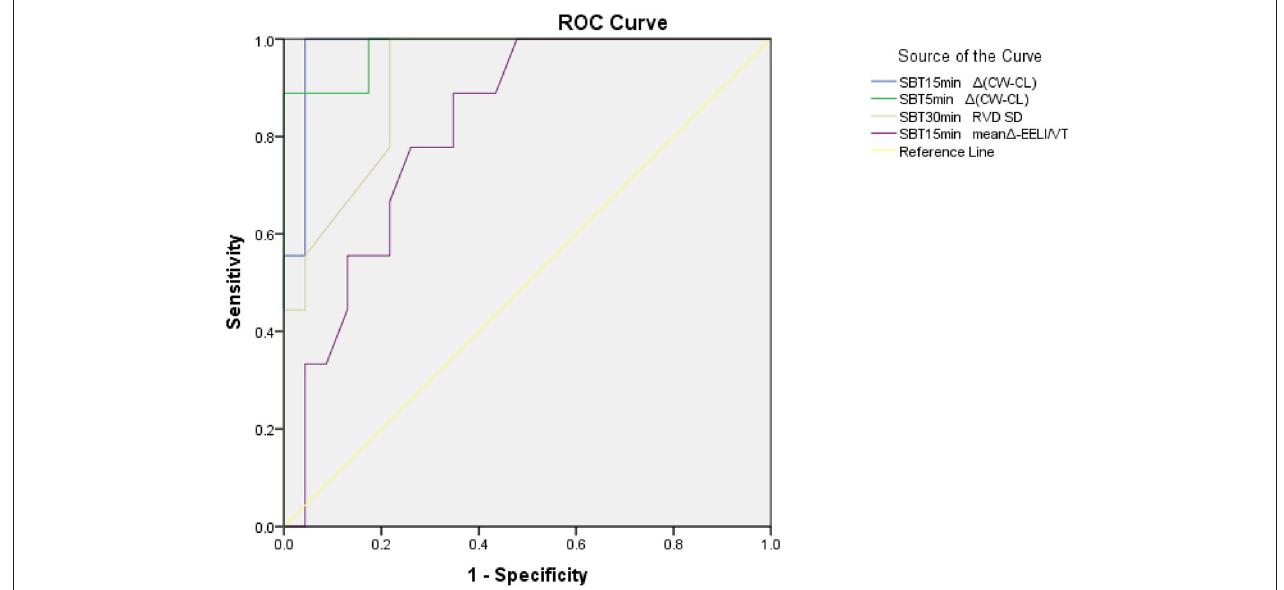
FIGURE 1 | A ROC of prognostic variables for patients. 1 EELI/Vt, change from baseline of the end-expiratory lung impedance/the tidal volume in percentage; RVDSD, standard deviation of regional ventilation delay index; 1 (CW-CL), compliance change percentage variation; GI, global